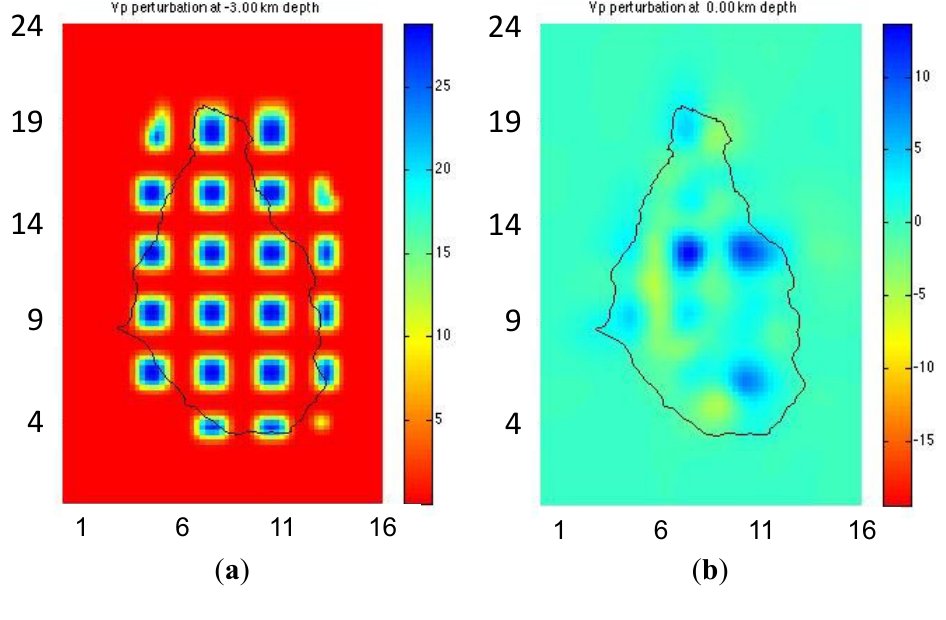
Figure A5. Checkerboard test results for anomalies at ( b ) 0 km; ( c ) 0.5 km; ( d ) 1 km; ( e ) 2 km; ( f ) 3 km and ( g ) 4 km depths; ( a ) is the source pattern for the checkerboard test (shown at 3 km depth). The x and y -axes indicate distance in km east and north respectively. The colour scale indicates percentage velocity perturbation. Synthetic noise with a zero-mean Gaussian distribution and 0.02 s standard deviation was added to the travel-time data. Note the variation in the amplitudes of